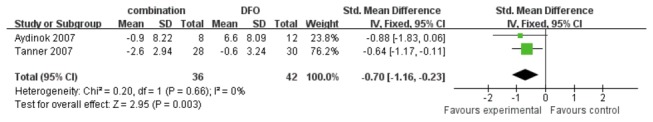
Forest plot analysis of outcomes of LVEF as difference of means and standard deviations from before and after the study between combination therapy and DFO.